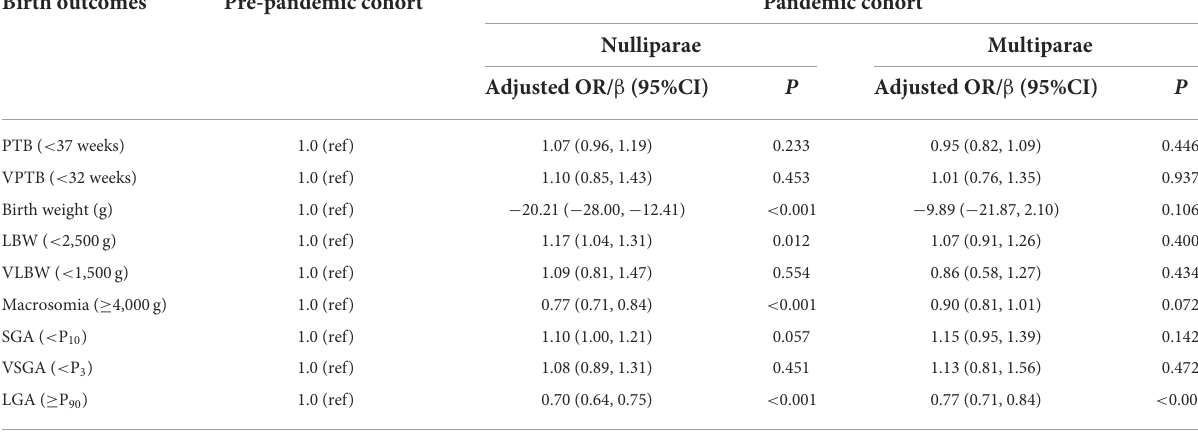
TABLE 5 Stratified analyses on the association between COVID-19 pandemic and birth outcomes by parity. Birth